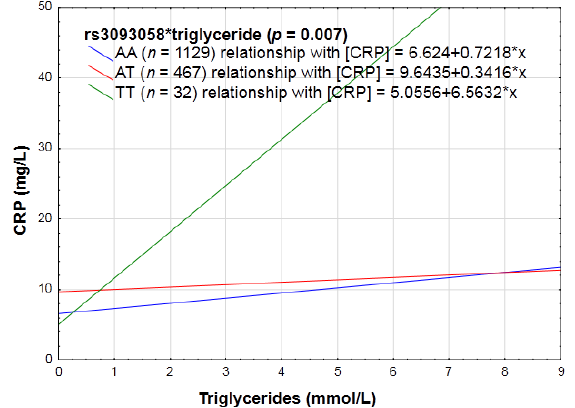
Figure 2. The linear relationship between triglycerides in relation to CRP concentrations categorized for